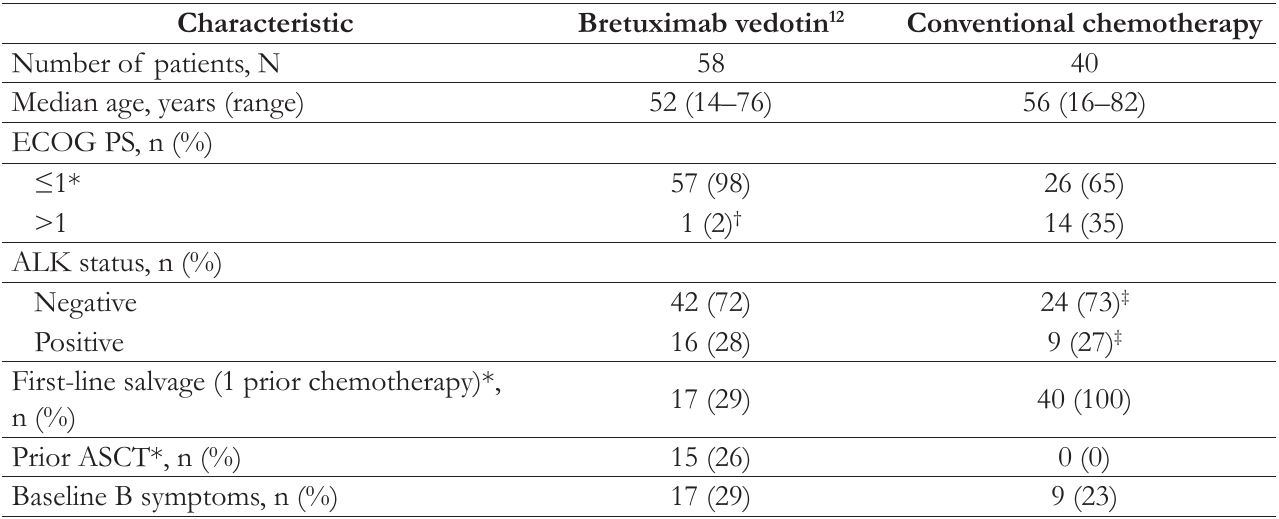
Table 1. Patient Demographics, Disease Characteristics and Risk Factors